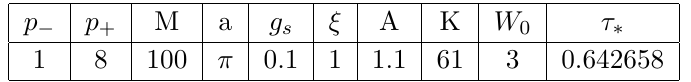
Table 1. arameters used to compute the cosmological constant in the LVS